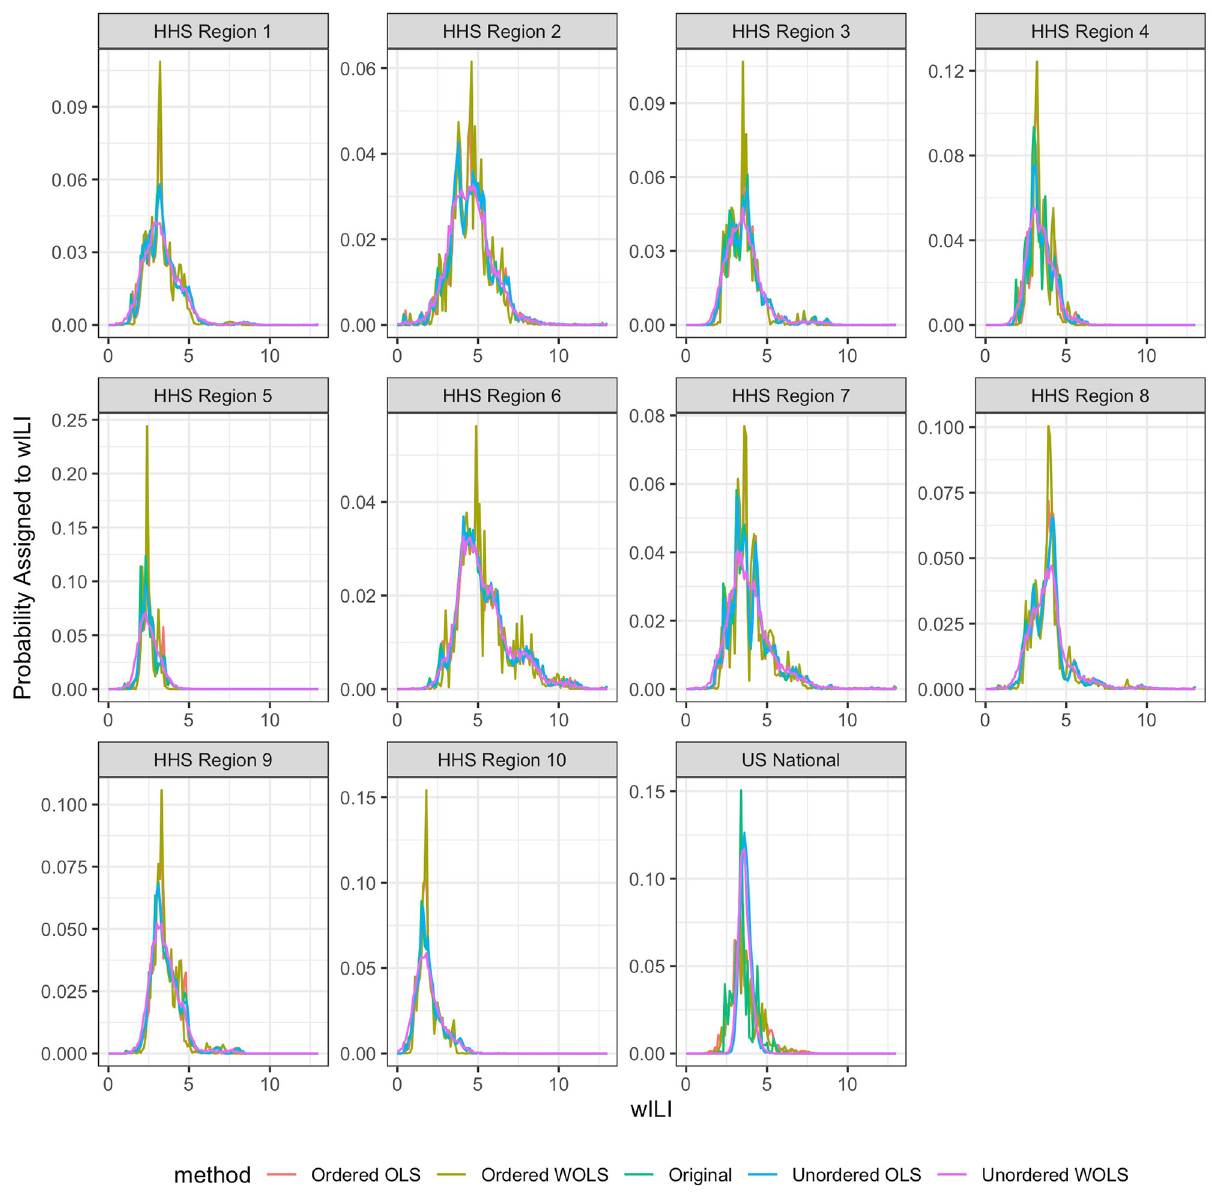
Fig 4. Real data example of model predictive densities for the 1 week ahead target on epiweek 201901 for the 2018/2019 season across all 11 regions. The y-axis represents the probability density for a given wILI bin value on the x-axis. Notice how the regional samples do not change much under the coherence constraint, but the national forecasts noticeably change. We can also see variable levels of density “smoothing” produced by each method, with the greatest amount of smoothing under the Unordered weighted ordinary least squares (WOLS) method. This smoothing of forecast density also lowers the magnitude of the peak density across all HHS regions, but increases the magnitude of the peak in the nation. However, the overall location of the forecast density remains consistent across all projection methods.